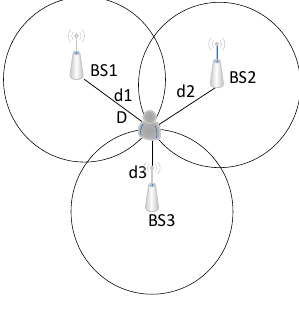
Figure 1. Principle of trilateration based on TOA (time of arrival) method.